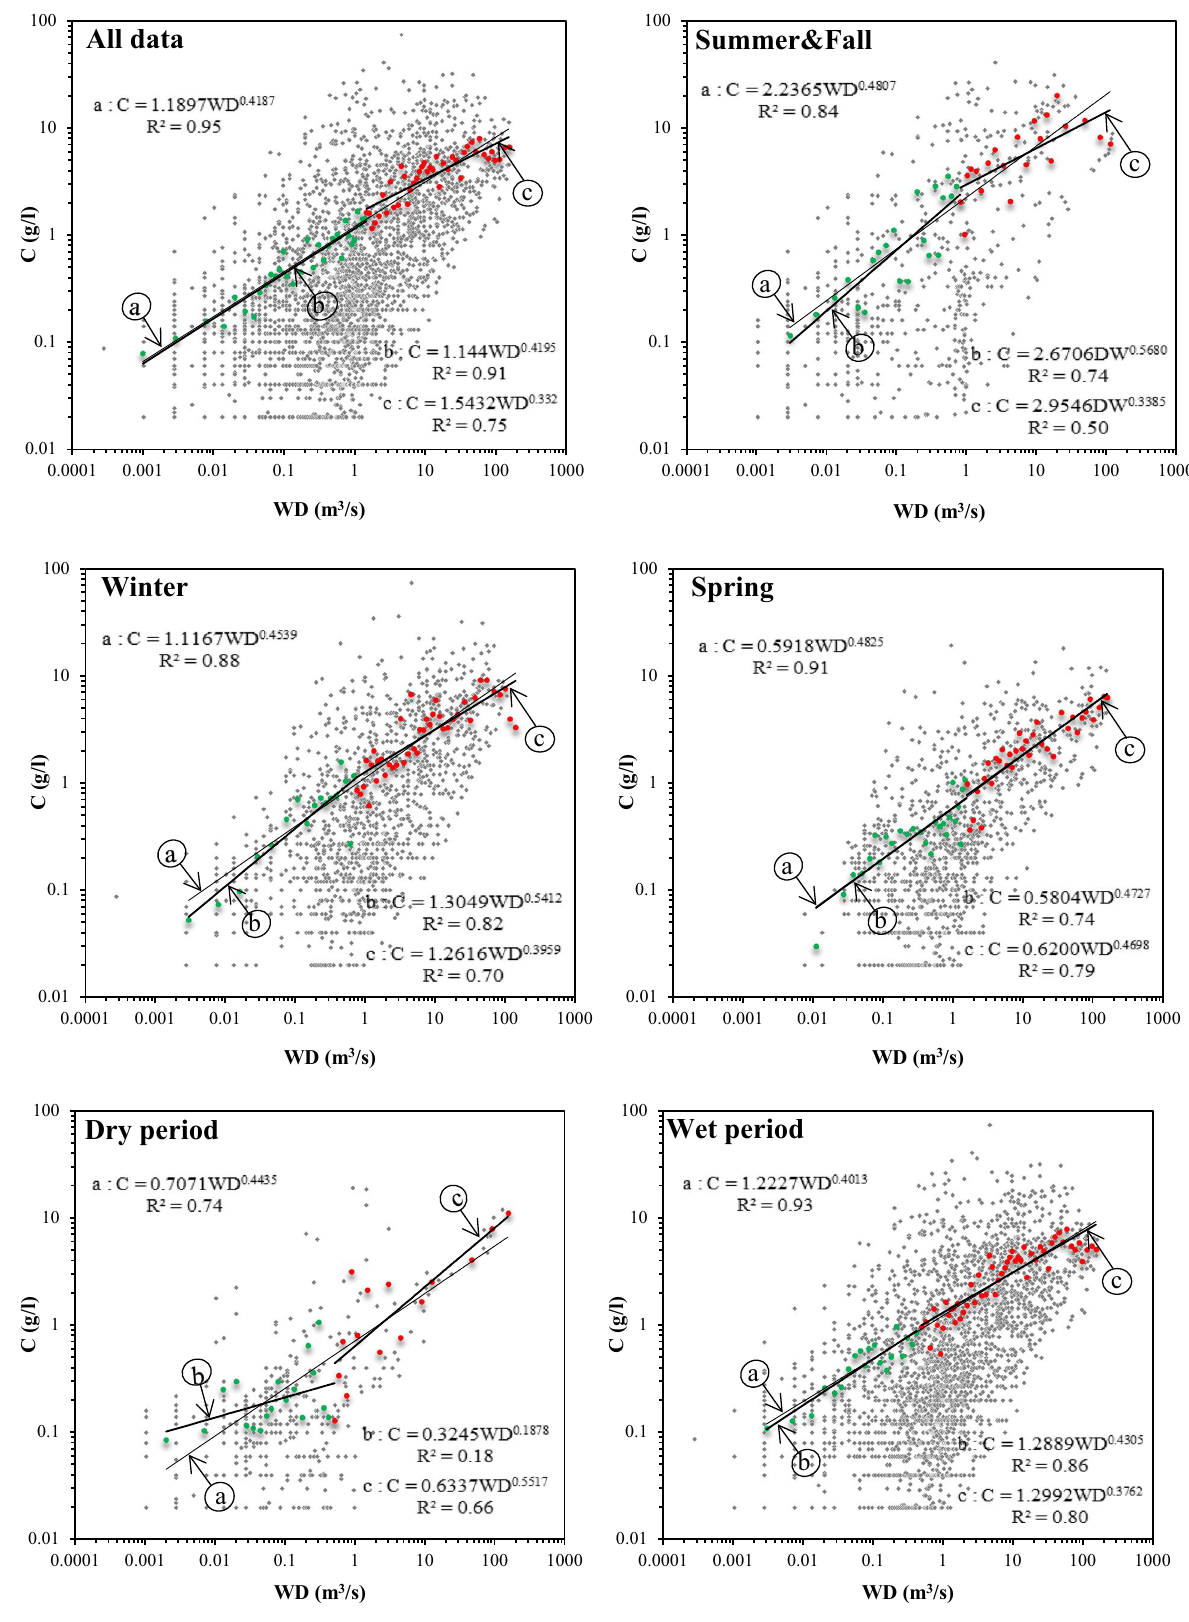
Fig. 4 Scatter plots of the annual, seasonal and periodical rating curve developed on means (WD and C ); a rating from a single best-fit calcula- tion; b rating from low-medium flow; c rating from